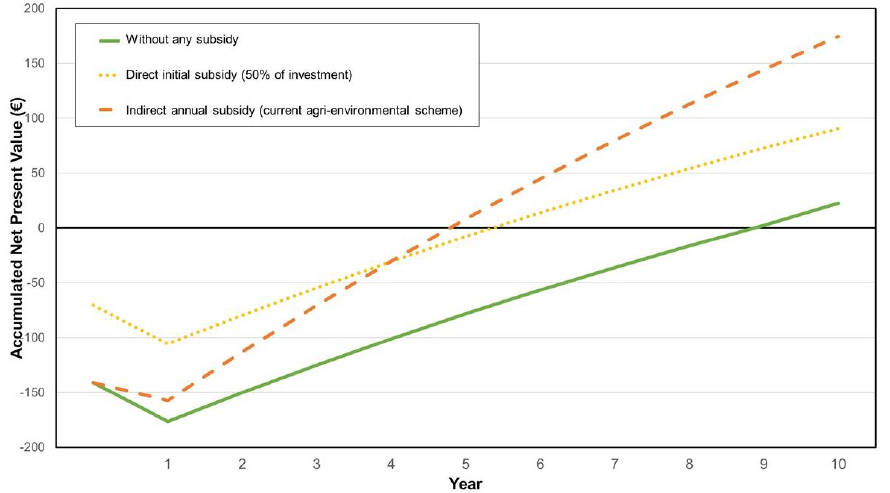
Figure 4. The accumulated net present value ( € ) with 1.05% discounted rate per annum; estimated from the benefits derived from yield increase by pollination and the costs of installing and maintaining the flower strips. Scenario 1, no subsidy; Scenario 2, with a hypothetical direct initial subsidy financing 50% of the initial cost of flower strip installation; Scenario 3, with an indirect subsidy based on Spanish Royal Decree 27/2018, where melliferous fallow land is considered an ecological focus area (EFA) with a weighting coefficient of 1.5 in relation to other fallow